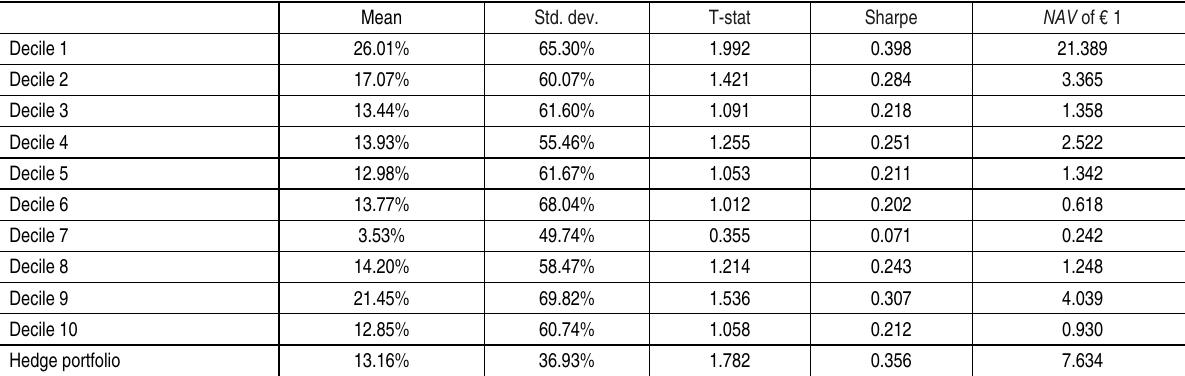
Table 1b. Performance statistics on accrual portfolios of % accruals Mean